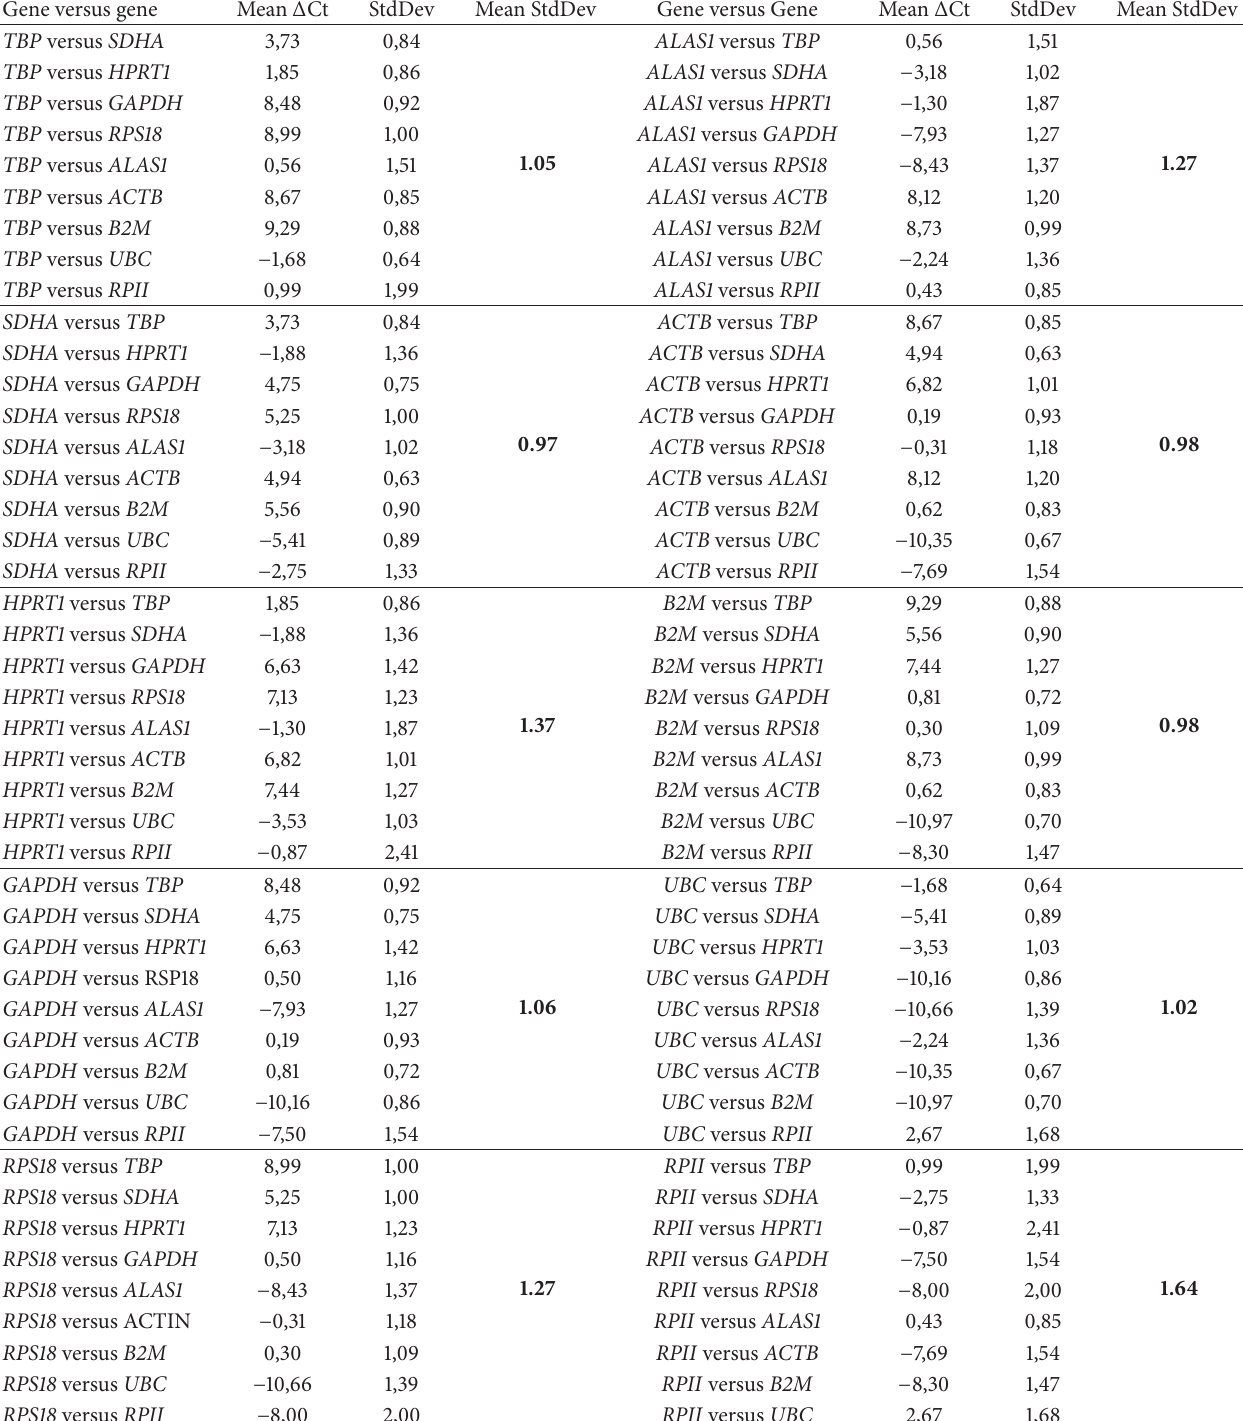
Table 3: The Δ Ct comparative method analysis for